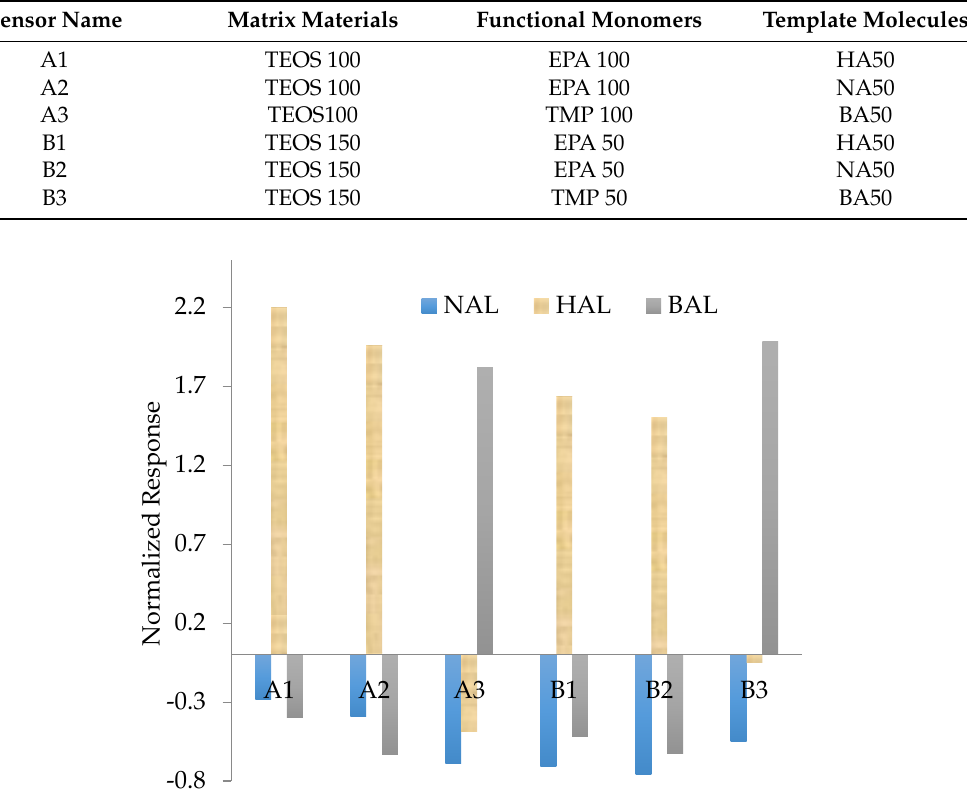
Table 4. Sensor channels with different volume ratio of TEOS/EPA: A = 100/100 and B = 150/50.